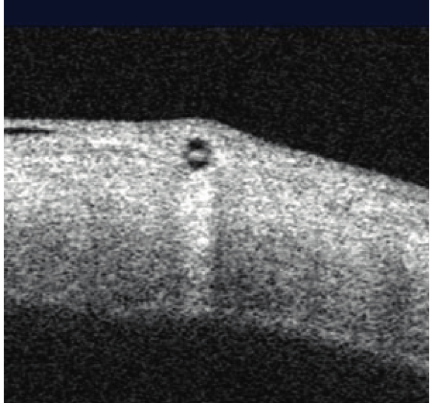
Figure 4: Complications of XEN implantation—an optical co- herence tomography image showing protrusion under the